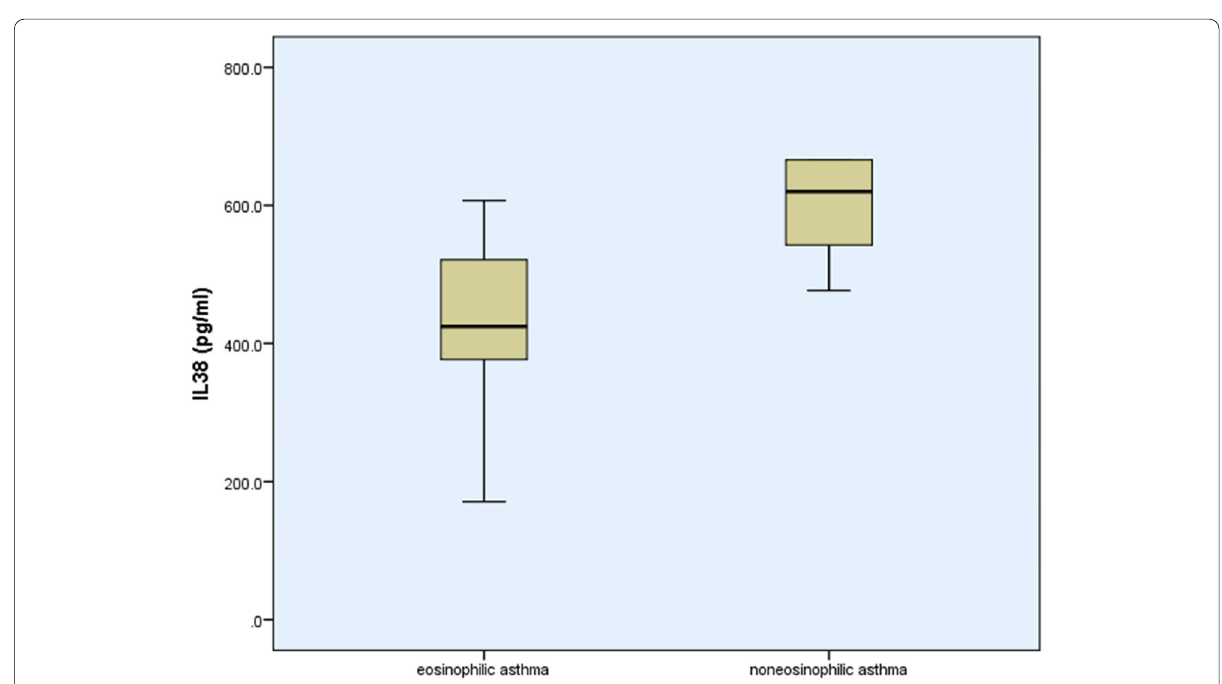
Fig. 6 IL-38 serum levels in atopic patients with and without eosinophilic